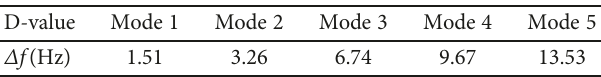
Figure 7: Temperature distribution of the radiation equilibrium at the wall (K) at M Table 2: The di ff erence of the fi rst fi ve natural frequencies between case 1 and case